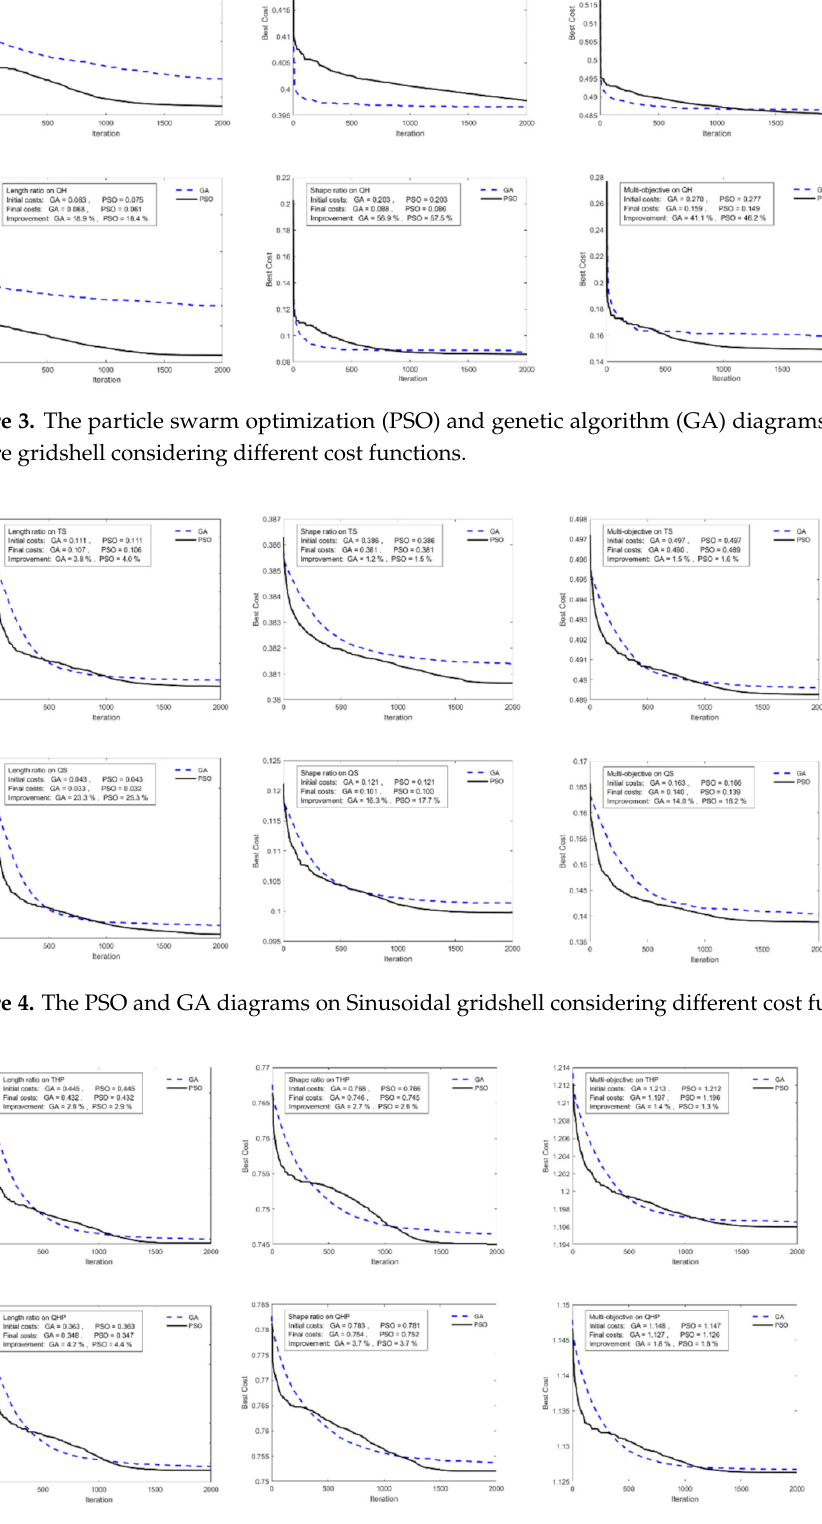
Figure 5. The PSO and GA diagrams on Hyperbolic Paraboloid gridshell considering different cost